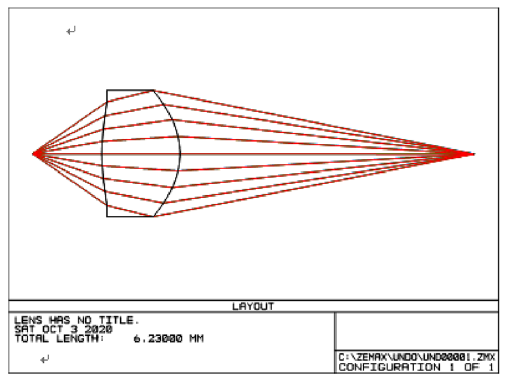
Figure 5. 2D optical layouts plotted by Zemax for the designed coupling aspheric lens.